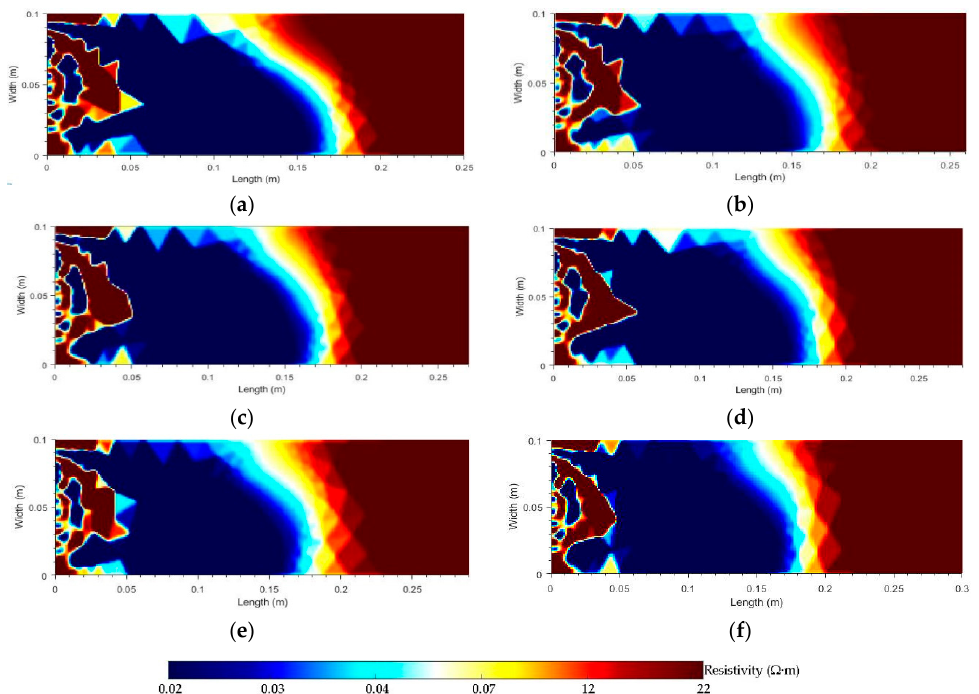
Figure 9. Inversion results of virtual grounding electrode at different distances when L = 0.15 m and 𝐼 (cid:2868) = 𝐼 (cid:2869) = 1 mA. ( a ) Is the inversion result when D = 0.24 m; ( b ) is the inversion result when D = 0.25 m; ( c ) is the inversion result when D = 0.26 m; ( d ) is the inversion result when D = 0.27 m; ( e ) is the inversion result when D = 0.28 m; ( f ) is the inversion result when D = 0.29 m.